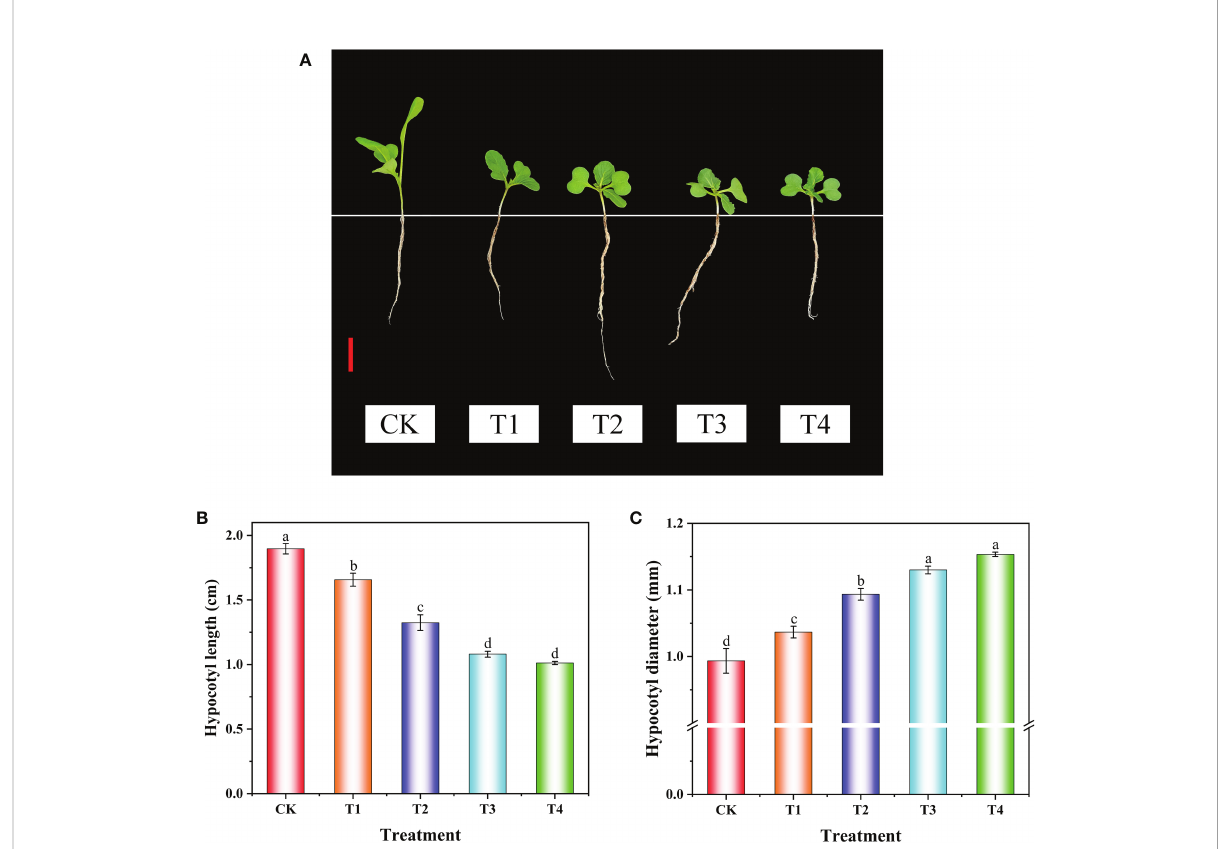
FIGURE 1 The phenotype and hypocotyl growth of fl owering Chinese cabbage seedlings under uniconazole treatment. The phenotype (A) , length (B) , and diameter (C) of hypocotyl at 9 days after uniconazole treatment in fl owering Chinese cabbage seedlings. CK, 0 mg·L -1 uniconazole (pure